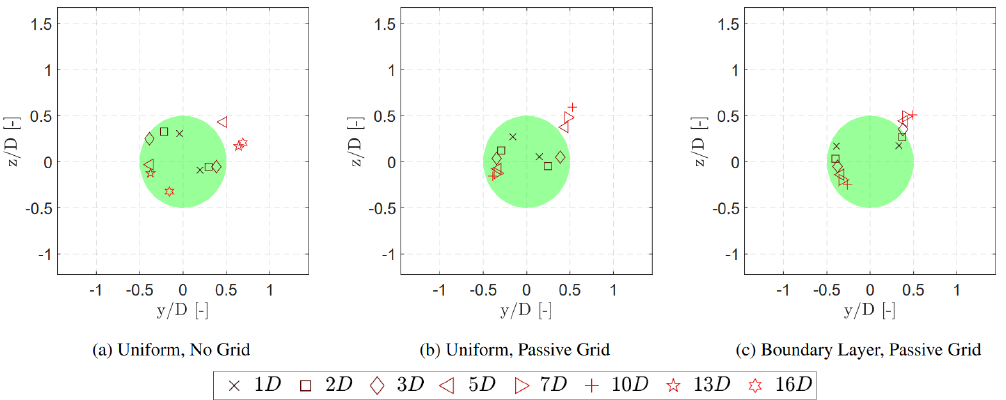
u i − u i, ∞ ) for each inflow condition at each u i, ∞